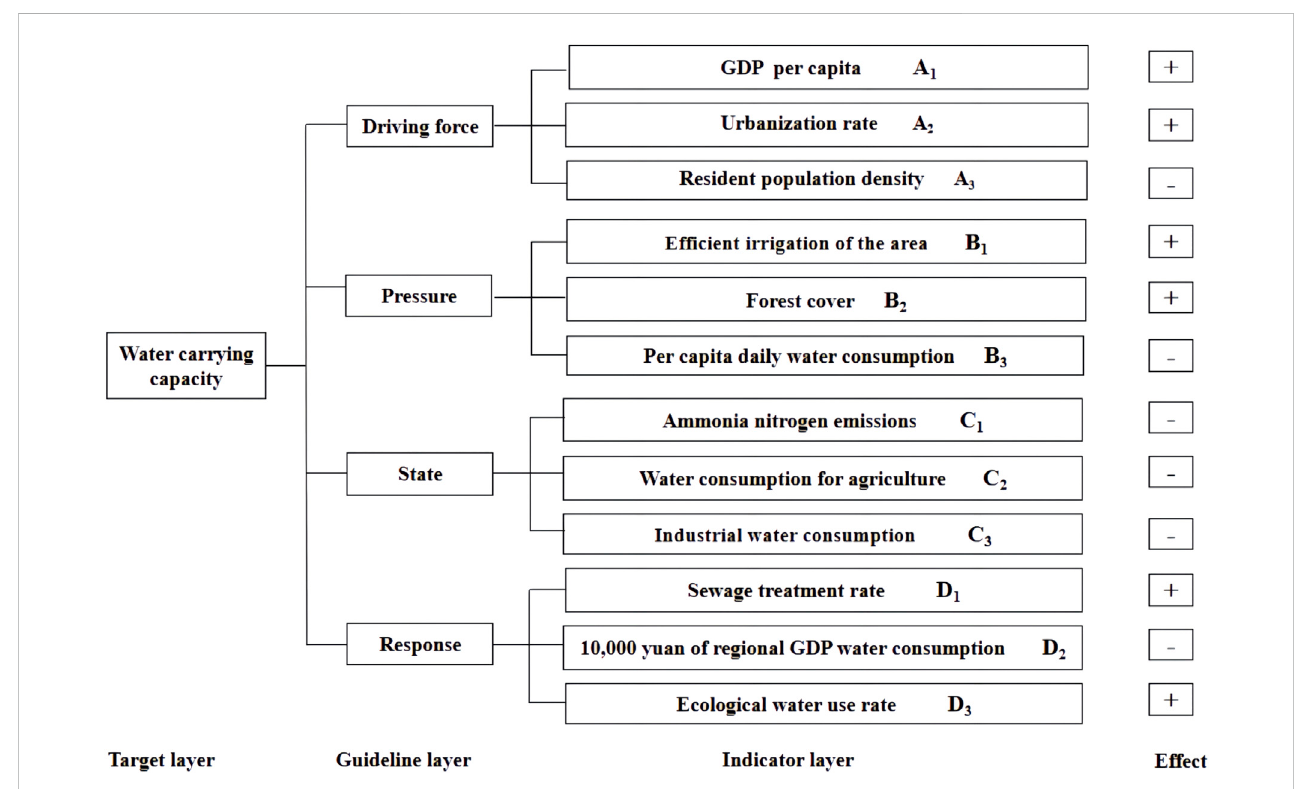
FIGURE 3 Evaluation index system of water resource carrying capacity in Chicheng County.